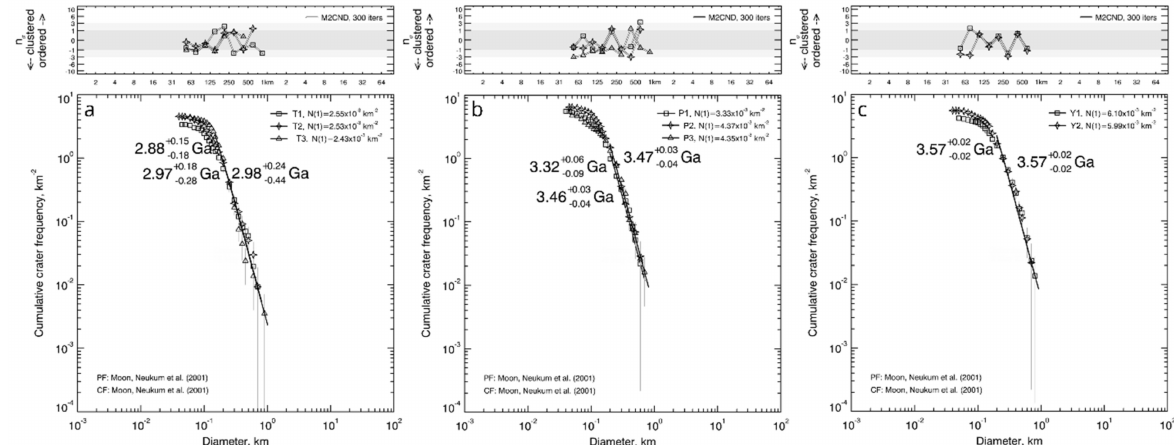
Figure 7. Crater size–frequency distribution (CSFD) measurements performed for areas located on the Tsiolkovskiy crater floor. ( a ) Age results for the orange color unit (i.e., bp1 unit); ( b ) age results for the purple-blue color unit (i.e., bp2 unit); and ( c ) age results for the yellow color unit (i.e., bp3 unit). The randomness analysis results are shown in the panels above the